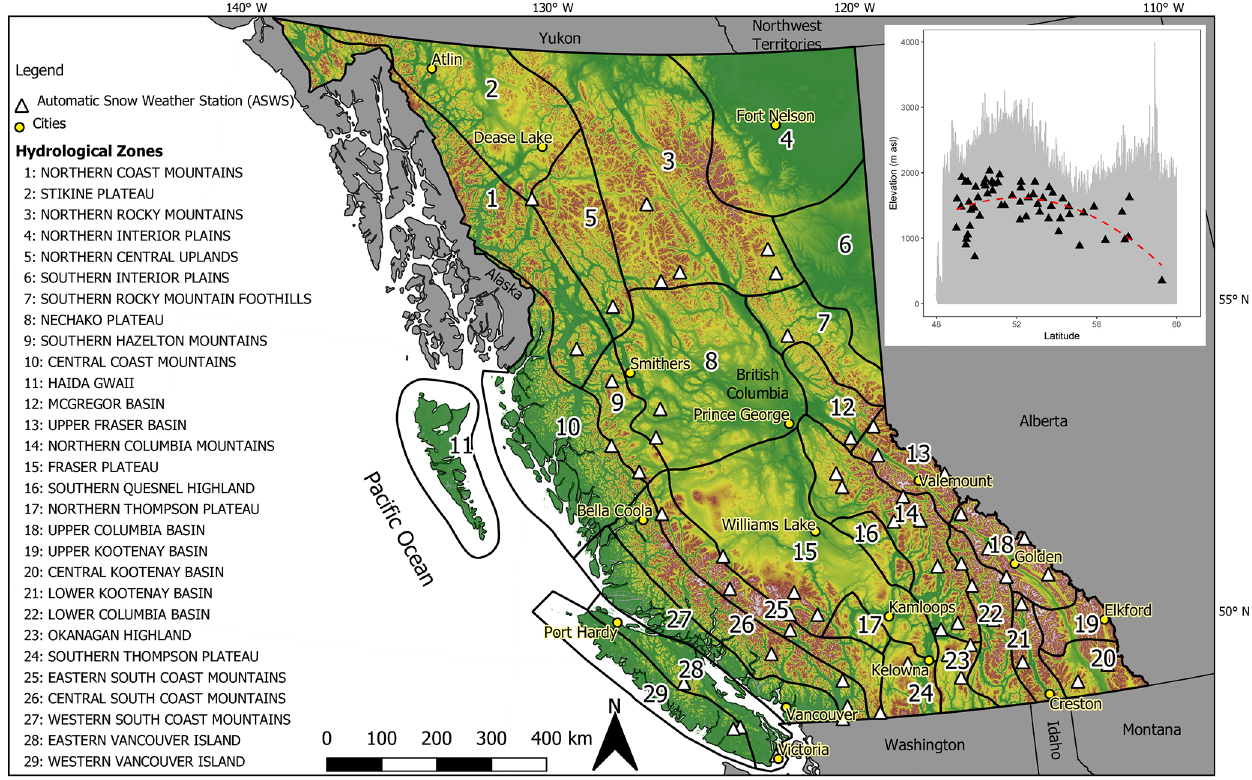
Figure 1. Map of British Columbia, Canada, shown with hydrozones, automated snow weather stations (ASWSs), and selected cities. The inset shows the distribution of ASWS locations by latitude ( x axis) and elevation ( y axis) plotted against terrain elevation (grey line) with a polynomial fit to the data (dashed red line), indicating gaps in the in situ observations in northern BC, particularly at high